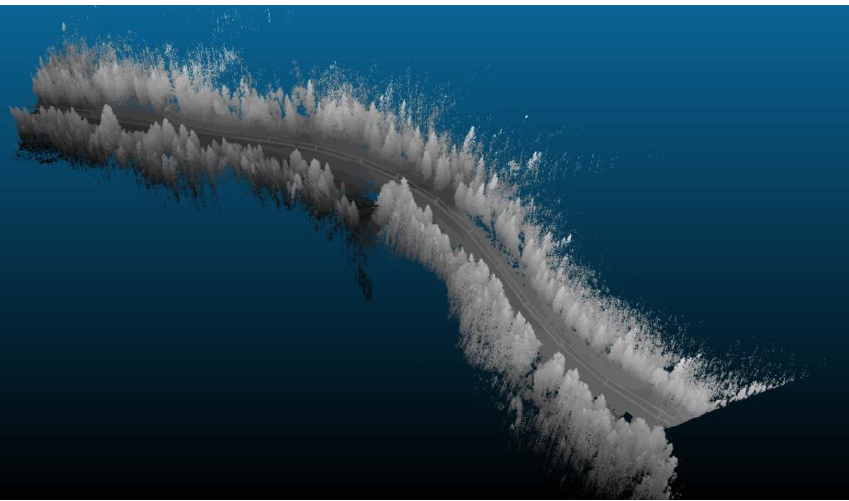
Figure 13. LIDAR dataset of Austrian railroad corridor, scanned by an Optech Lynx mobile mapping system.